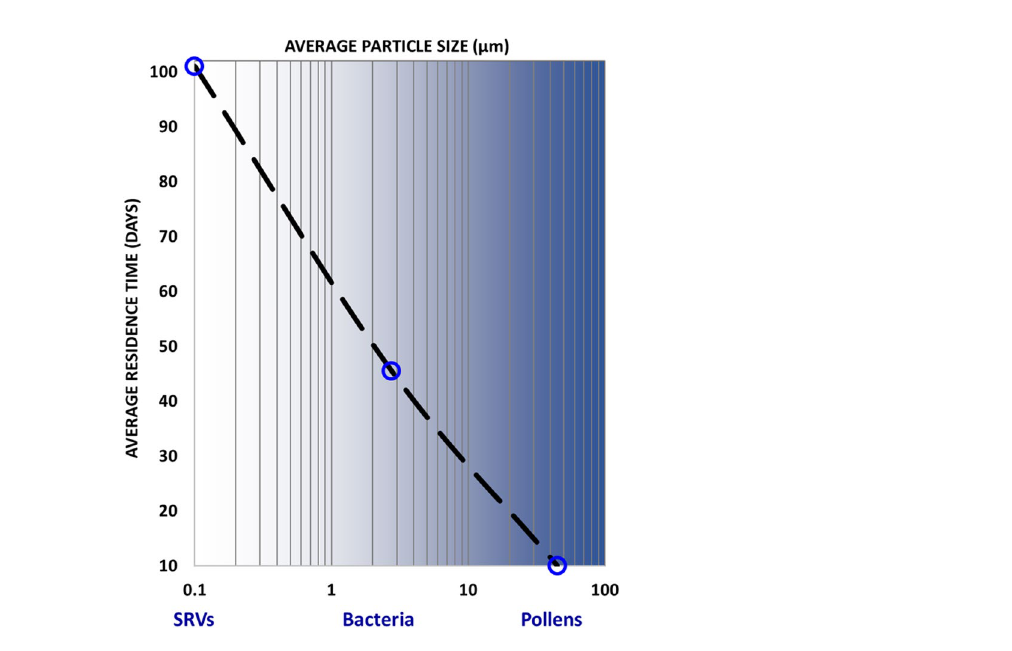
Figure 1. Average residence time of atmospheric particles as a function of particle size. Adapted from Table 1, Anastasio and Martin 17 and Kreidenweiss et al. 18